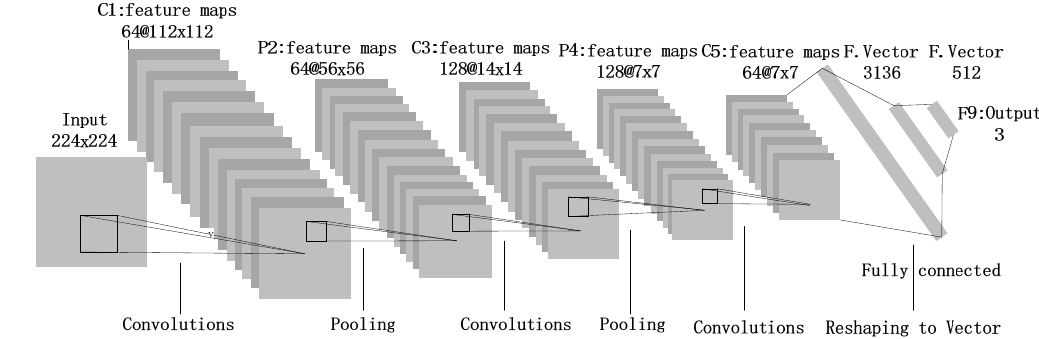
Figure 5. The architecture of the designed CNN model.